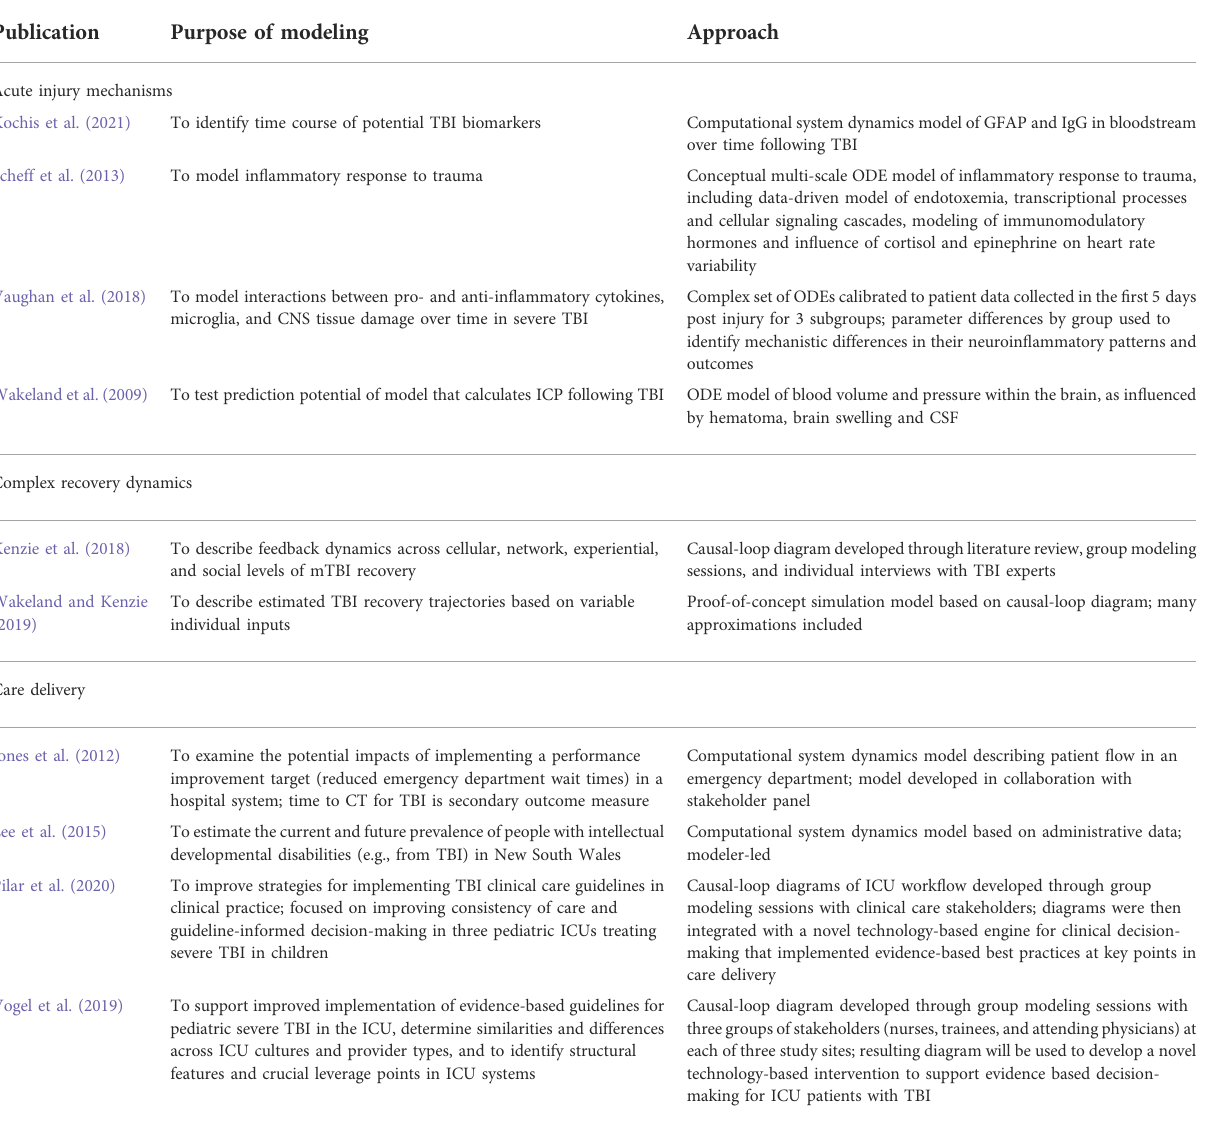
TABLE 1 Applications of system dynamics modeling for traumatic brain